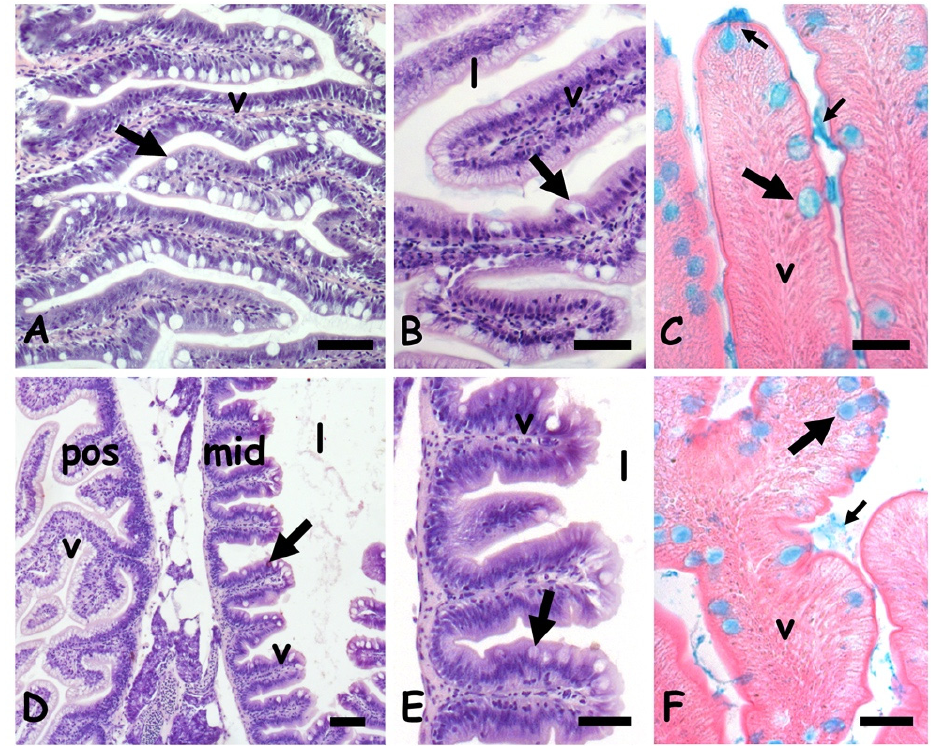
Figure 1. Danio rerio anterior ( A – C ) and mid ( D – F ) intestine. ( A ) Long villi (v) lined by a mucosal epithelium rich in goblet cells (arrow). ( B ) Detail of villi (v); lumen (l), goblet cell (arrow). ( C ) Goblet cells (large arrow) and luminal mucus (small arrow) positive to the Alcian blue staining. ( D ) Villi (v), goblet cells (arrow), and lumen (l) in posterior (pos) and mid (mid) gut. ( E ) Detail of midgut villi. ( F ) Goblet cells (large arrow) and luminal mucus (small arrow) positive to the Alcian blue staining. Hemalum-eosin staining ( A , B , D , E ); Alcian blue-eosin counterstaining ( C , F ). Bars: 100 µm ( A , B , D ), 50 µm ( C , E , F ).